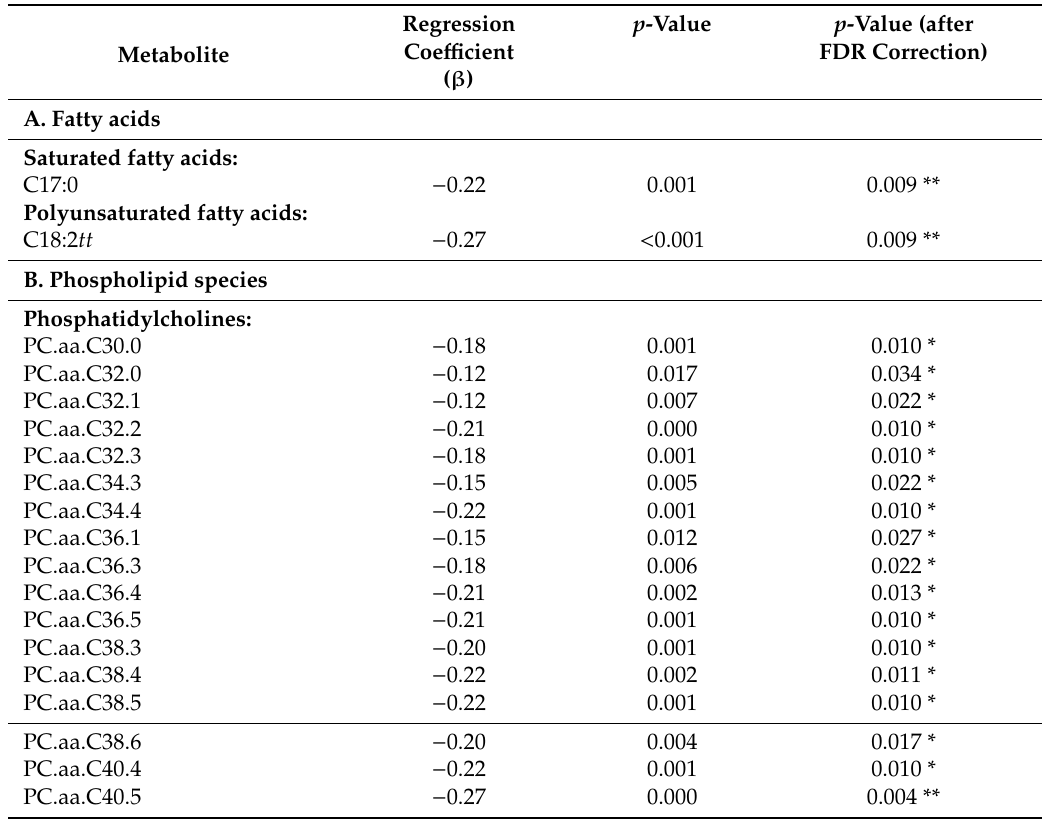
Table 7. Significant results from the linear models for the change in ( A ) total glycerophospholipid fatty acids and ( B ) phospholipid species with hemoglobin value at baseline in severe malnourished children treated with